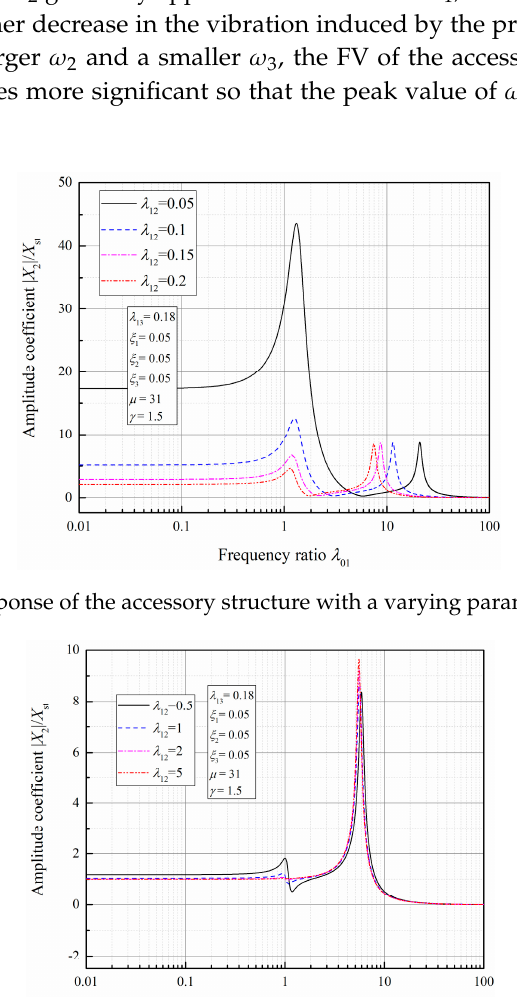
Figure 10. The dynamic response of the accessory structure with varying parameter .